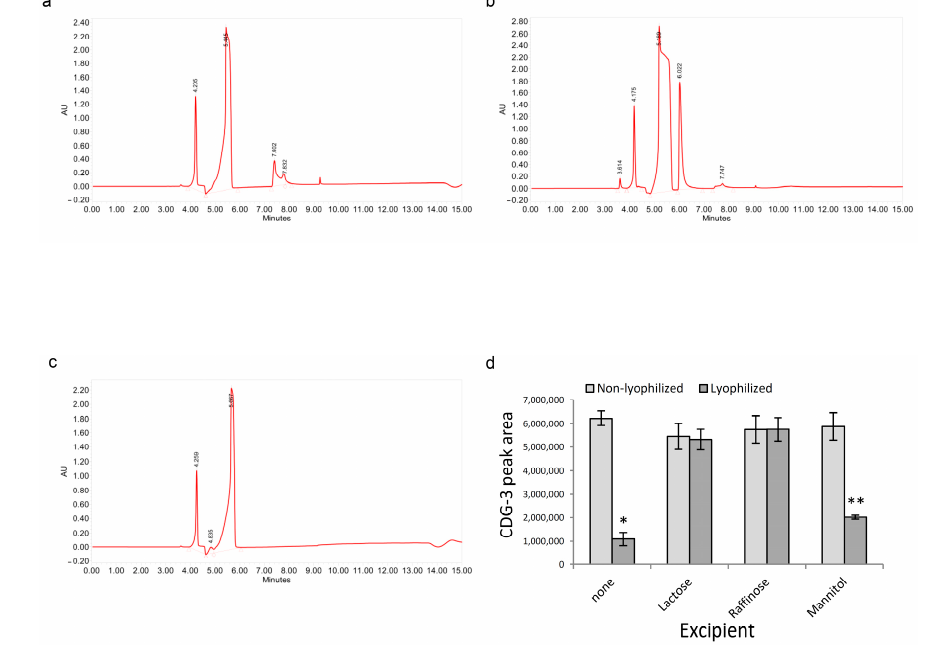
Figure 2. Sugar excipients helped retain CDG-3 HPLC peak area following lyophilization. CDG-3 in non-lyophilized and lyophilized forms was analyzed using HPLC. ( a )—HPLC curve with the intact CDG-3 substrate (double peak with retention at 7.4–7.8 min); ( b )—HPLC profile of the CDG-3 substrate after cleavage with the BlaC with the additional peak (reaction product) displaying retention at 6 min. Other peaks represent MES buffer; ( c )—MES buffer only; ( d )—Comparison of HPLC peaks representing CDG-3 unexposed to experimental conditions before and after lyophilization with retention at 7.5–7.7 min. Average of two experimental replicates per condition. Error bars—standard deviation. * p = 0.003; ** p = 0.011.